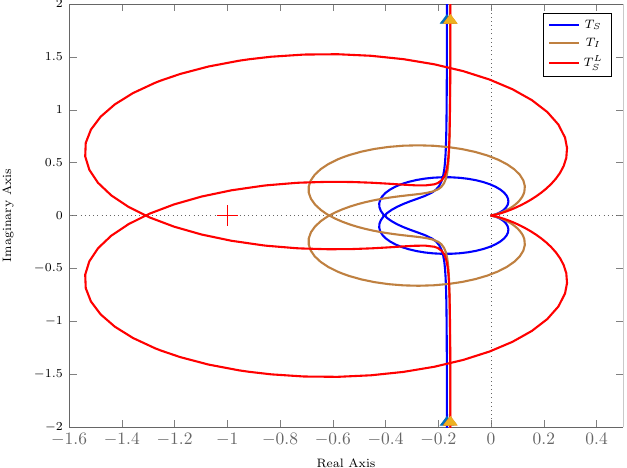
Figure 21. The unloaded, improved, and unstable loop gains of the source converter, depicting the ability of the proposed controller to stabilized the non-minimum phase